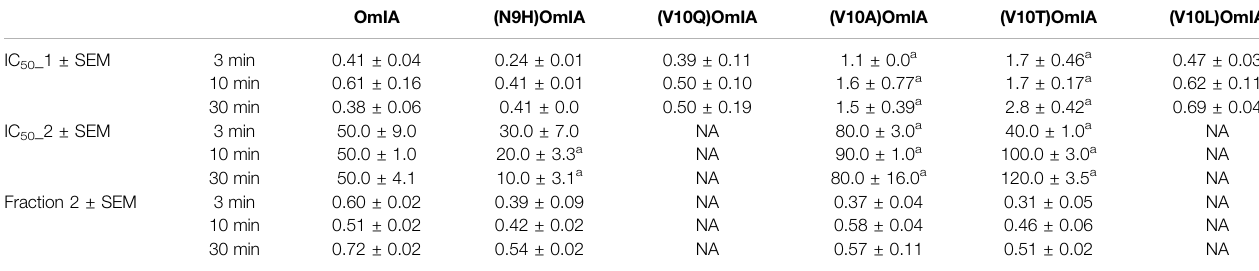
TABLE 5 | The IC 50 (µM) of OmIA and analogues following inhibitor preincubations of 3, 10 or 30 min at PNU120596-modi fi ed α 7 nAChRs. Data represent mean ± SEM of triplicate data from three independent experiments.